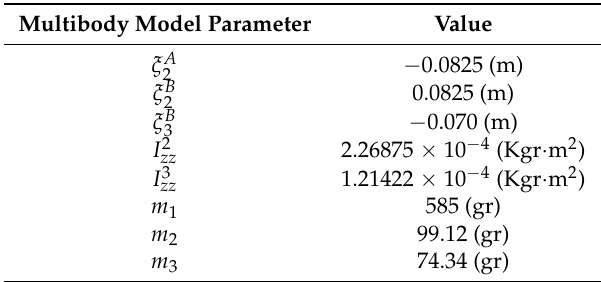
Table 1. Simulation